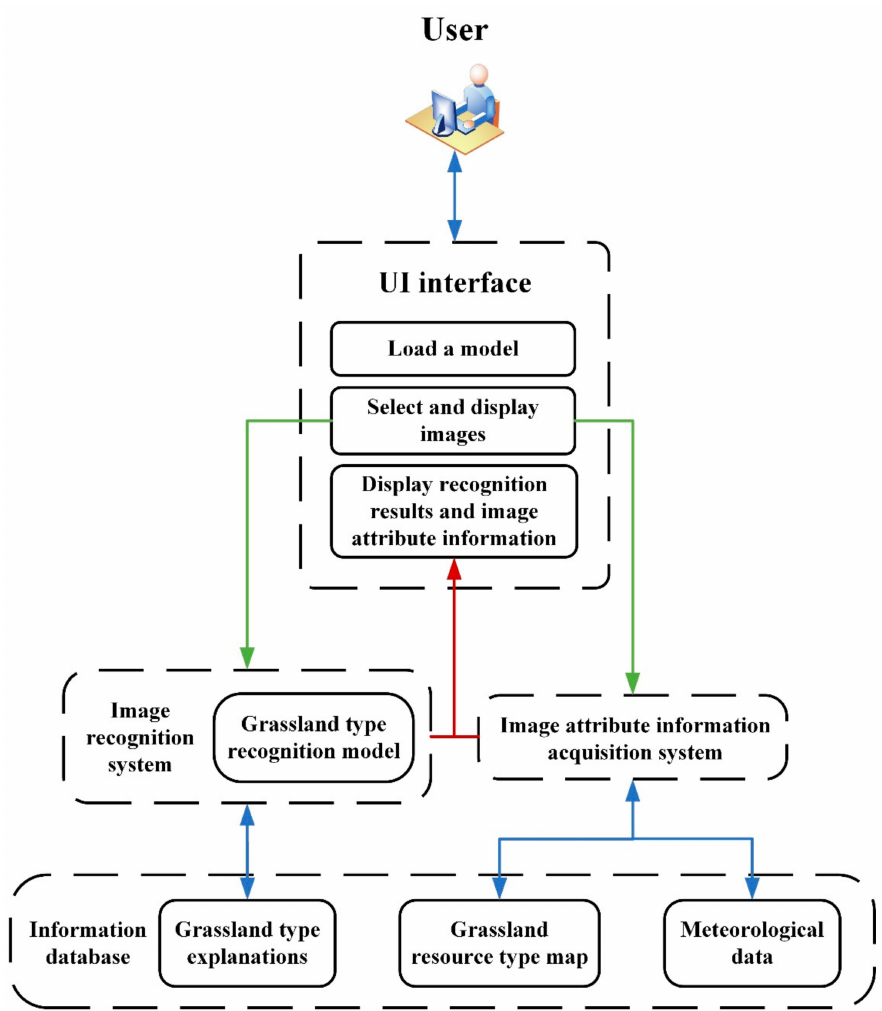
Figure 4. Architecture design of the grassland-type recognition